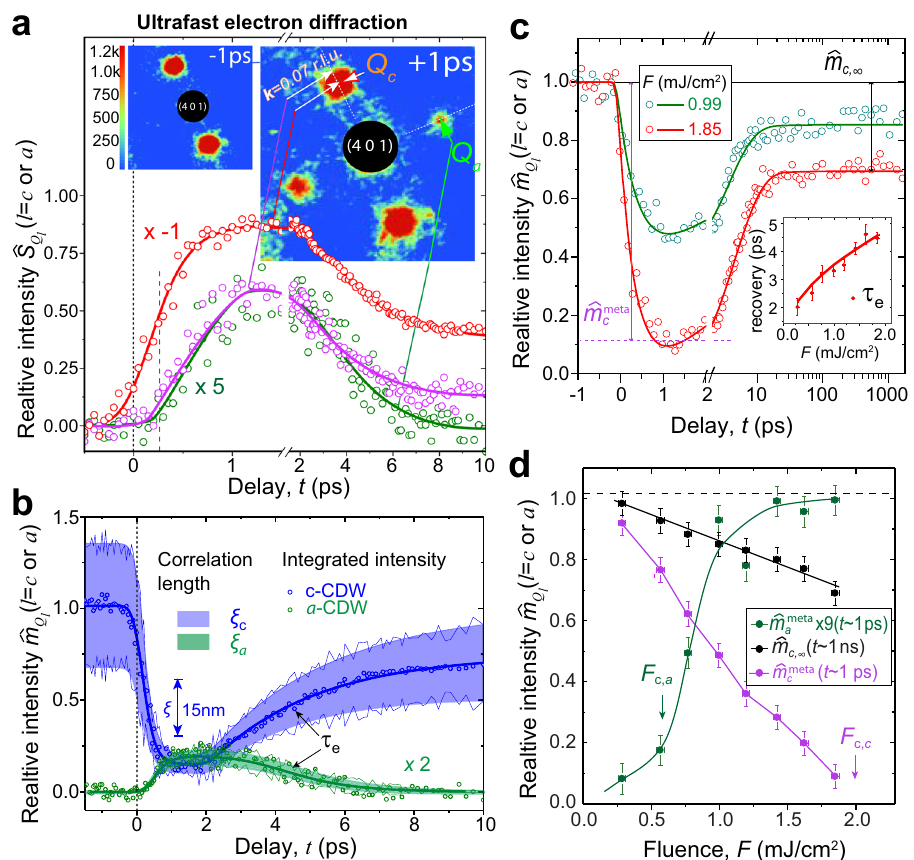
Fig. 3 Nonequilibrium CDW phase transitions. a The amplitude dynamics retrieved from the satellite structure factors obtained by ultrafast electron diffraction under F = 1.85 mJ/cm 2 . The dynamics from each CDW order are color-coded: the pre-existing c -CDW state in red, and the emerging c + -CDW and a -CDW states in purple and green, respectively. Top inset images show the diffraction patterns before and after laser quench with clear emergence of a -CDW satellite at Q a while the pre-eminent c -CDW satellite loses strength. b The panel shows the comparison between the evolution of the static c -CDW and the emerging a -CDW based on integrated intensity. The correlation length ( ξ ) of each state is also presented in the shaded envelop. c The intensity evolution obtained for two distinct fl uences, showing the general trends of the order parameter evolution with metastable and long-lived stages, where ^ m meta ^ m c ; 1 are extracted. The inset shows the recovery time, characterizing by the relaxation from the metastable to the long-lived stage. The error c and bars are the standard deviations from the fi tting. d The order parameter intensities at the metastable (for both a and c -CDW states) and long-lived stages extracted from a broad range of fl uences. The F c,a and F c,c are determined to be the nonthermal criti c al thresholds for a -CDW formation and c -CDW melting. The error bars represent the peak-to-peak noise of the dynamics at negative time